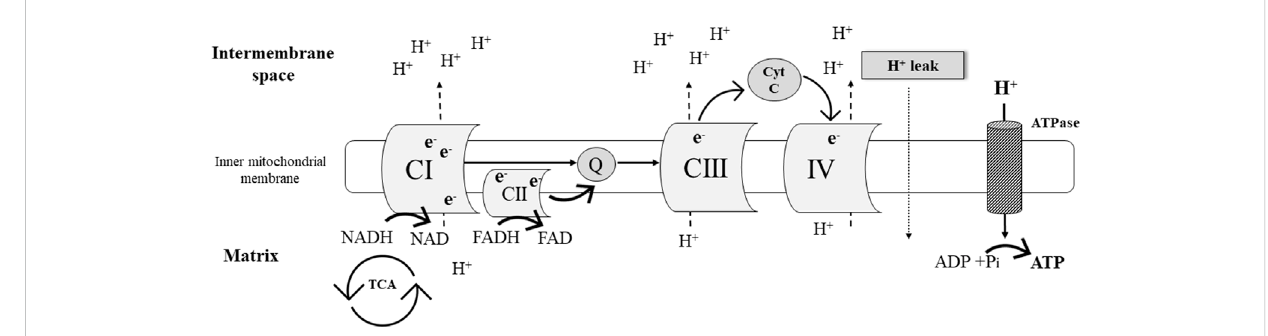
FIGURE 1 Simpli fi ed schematic representation of the mitochondrial electron transport